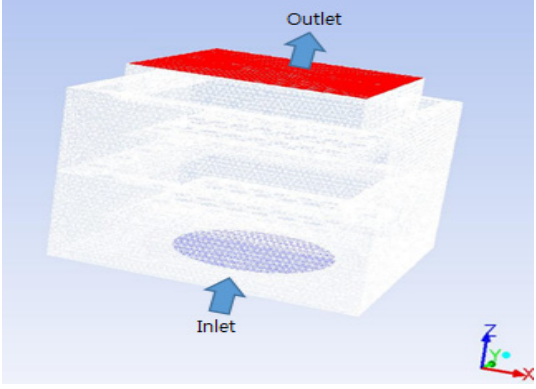
Figure 2. Mesh structure of non-powered hydraulic mixing with three layers of baffles.